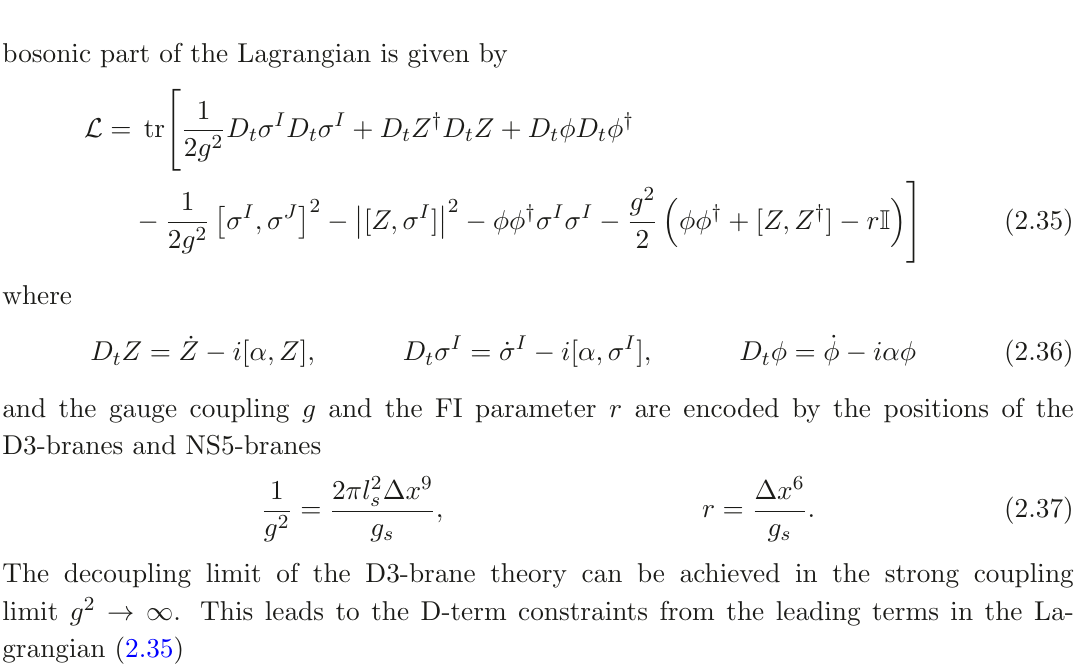
Figure 1 . N Vortices appear as N D1-branes in the 3d D3-branes attached on